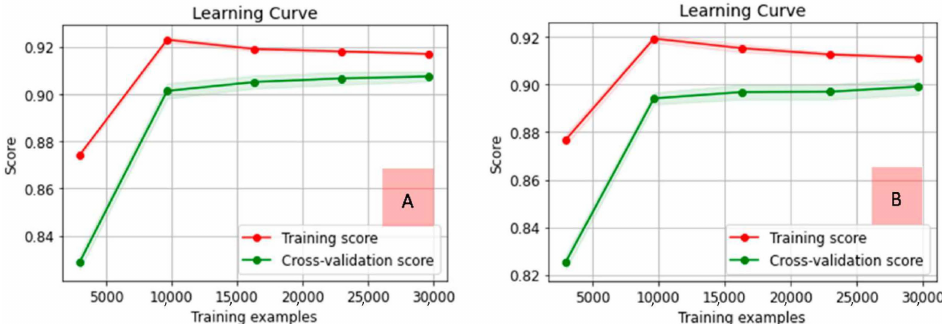
Figure 5. Learning curves for MNB with count ( A ) and TF–IDF ( B ) vectorizers and uni-grams.